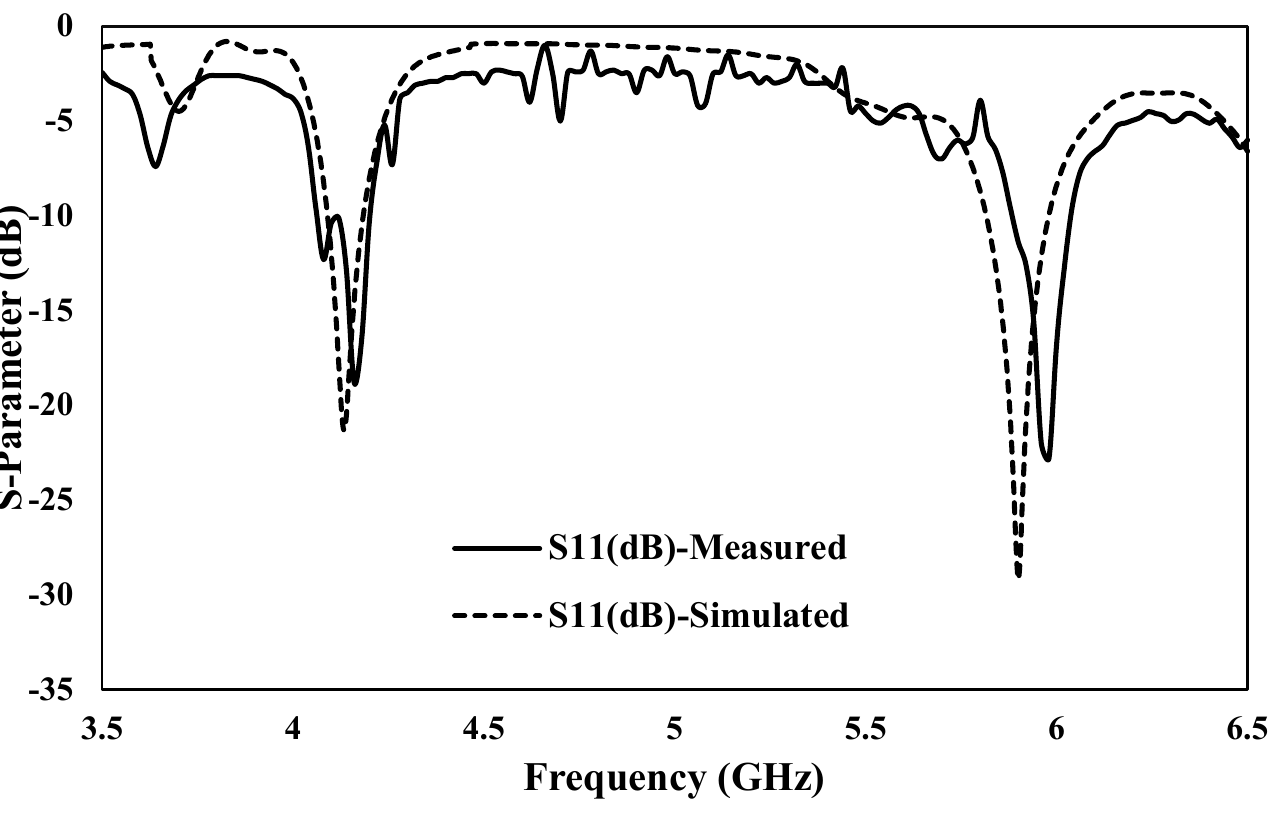
Figure 8. Shows the simulated and measured return loss S 11 (dB) of the four − element MSFAA. After the successful fabrication of the four-element MSFAA prototype, the S-parameter measurements are initially performed. Figure 8 compares the simulated and measured return loss S 11 (dB) of the four-element MSFAA. It can be seen from the results in Figure